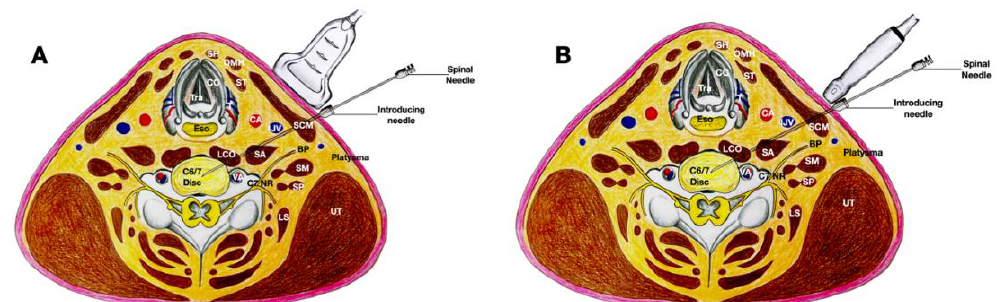
lateral side of the internal jugular vein and passing deeper to the internal jugular vein and carotid artery, using the double-needle technique. ( A ) The transducer is in the transverse plane of the neck and is placed more medially to the needle; an in-plane needle technique is used. ( B ) The transducer is in the sagittal plane of the neck and the needle is out-of-plane to the transducer. Abbreviations: